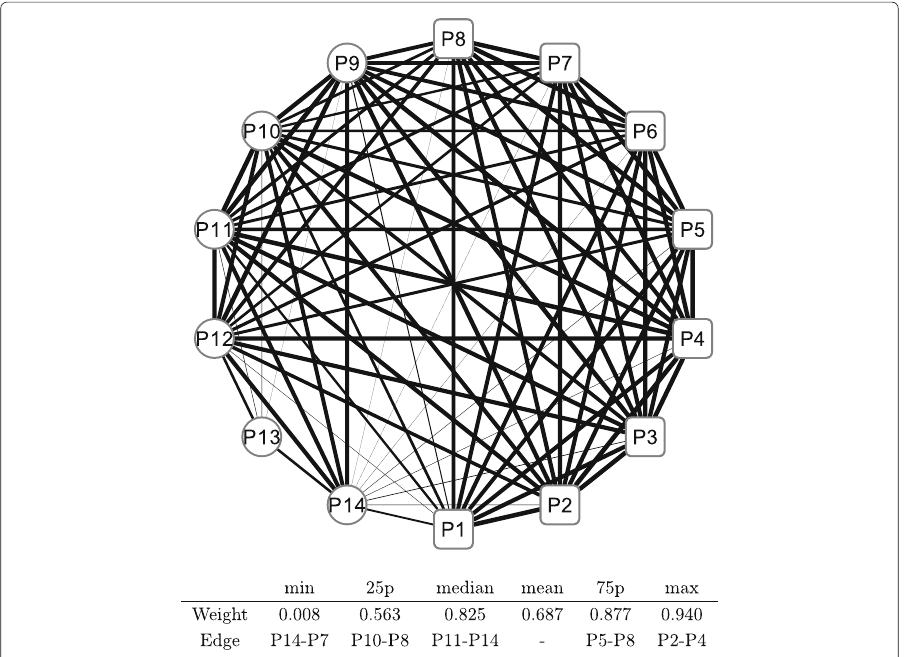
Fig. 8 Correlation network of sub-portfolios: whole period. Note: The network is created based on the network adjacency matrix of the whole observation period. The square nodes (labeled as P1, P2, ..., and P8) represent Cyclical sub-portfolios; the circle nodes (labeled as P9, P10, ..., and P14) represent Defensive sub-portfolios. The edge between nodes represents the degree of correlation of log returns between the two nodes. The edge width represents the weight of the corresponding entry of network adjacency matrix. The bottom table shows the quantiles of edge weights distribution with corresponding